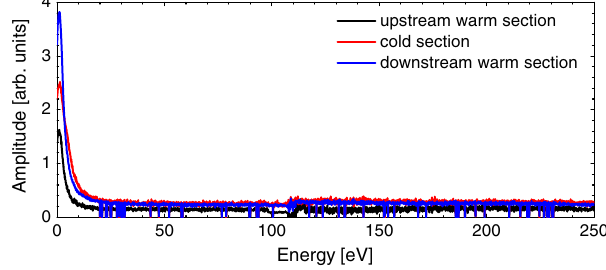
FIG. 10. Energy spectrum of negatively charged particles (electrons) in each section of COLDDIAG for energies up to 250 eV (energy resolution: 0.1 eV). Filling pattern: 250 mA average beam current, 685 bunches, 16 ps bunch length.